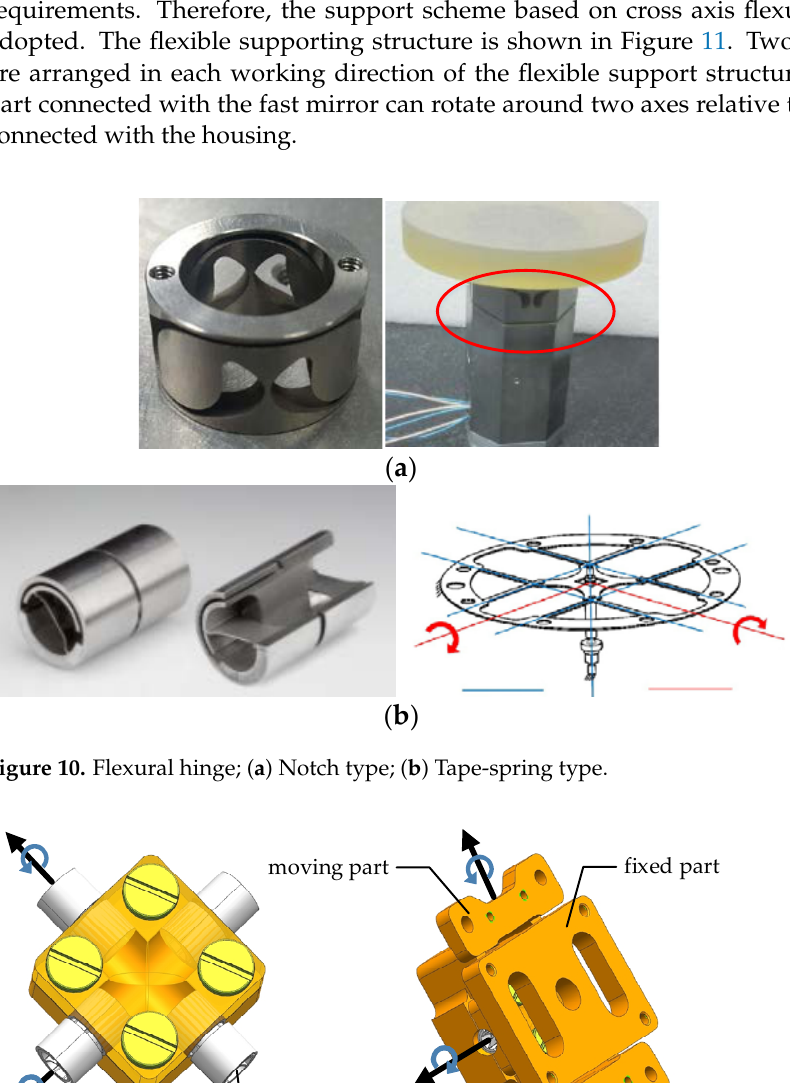
Figure 12. Cross axis flexural hinge with 3 variable cross-section tape springs. The finite element method is used to analyze the modes of the FSM and the results are shown in Figure 13. The first-order and second-order vibration modes rotate around the two working axes, and the corresponding frequencies, ( c ) Figure 13. Modal analysis results; ( a ) First-order mode; ( b ) Second-order mode; ( c ) Third-order mode.